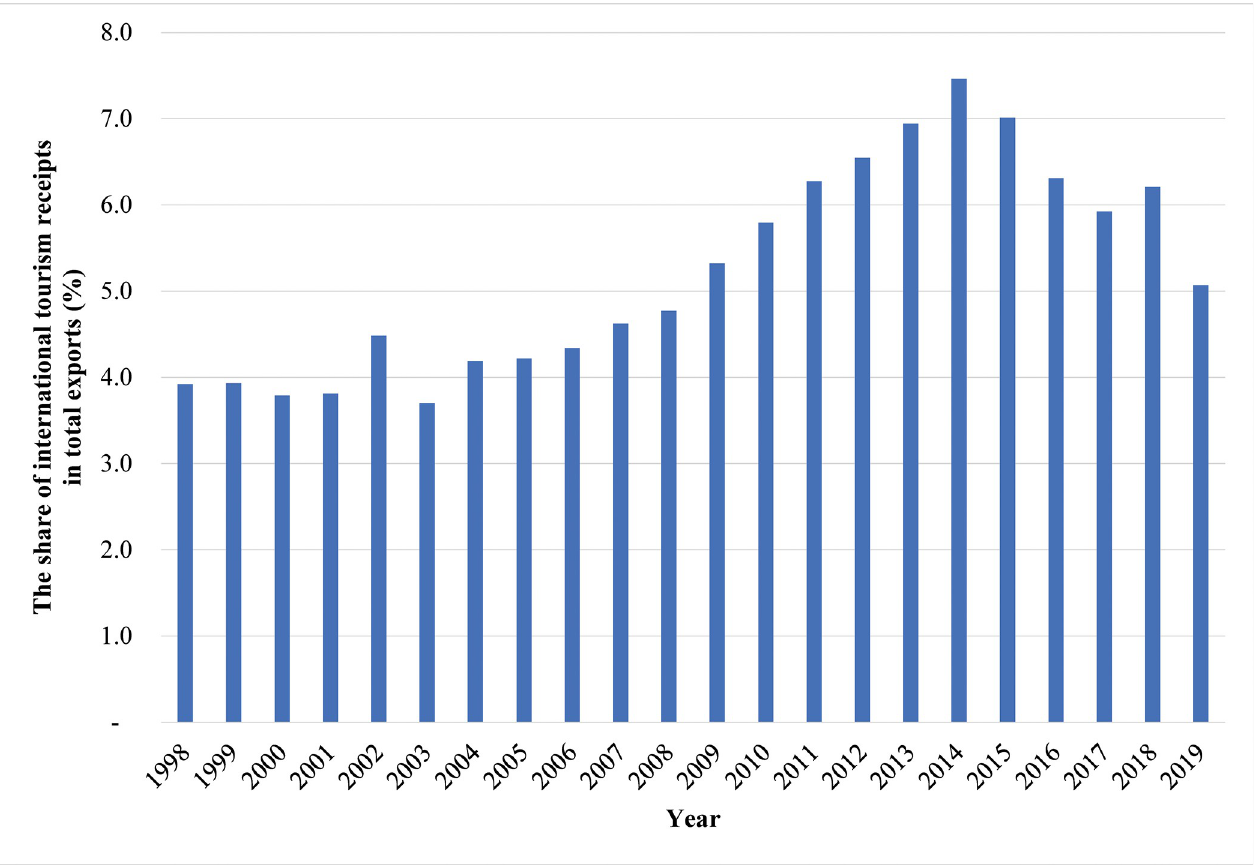
Fig 1. The share of international tourism receipts in Hong Kong’s exports, 1998–2019. Data source: The World Bank. https://data.worldbank.org/indicator/ ST.INT.RCPT.XP.ZS?locations=HK.